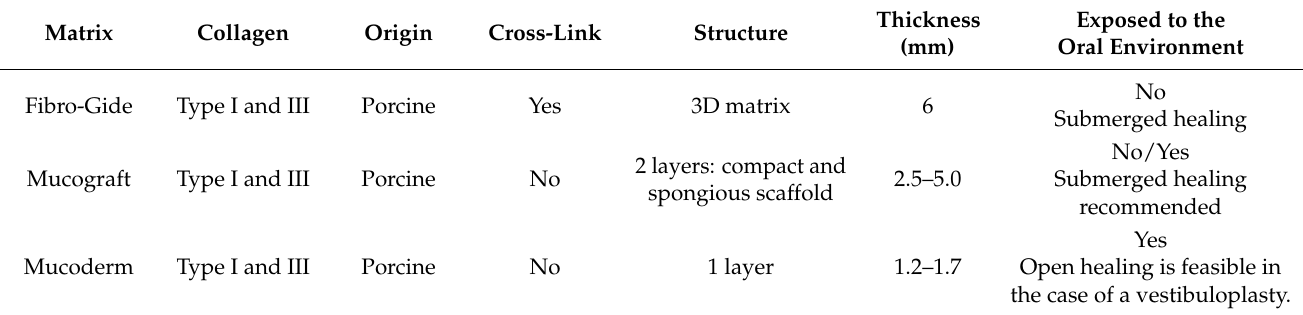
Table 1. Main characteristics of collagen-based matrices included in the